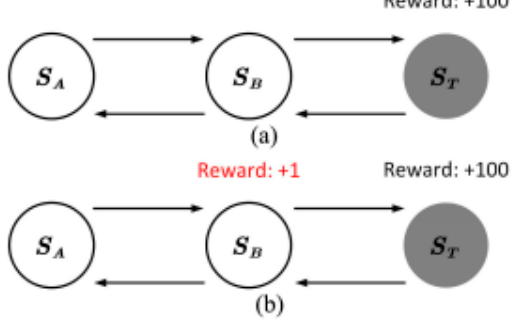
Figure 17. Reward shaping mechanism.